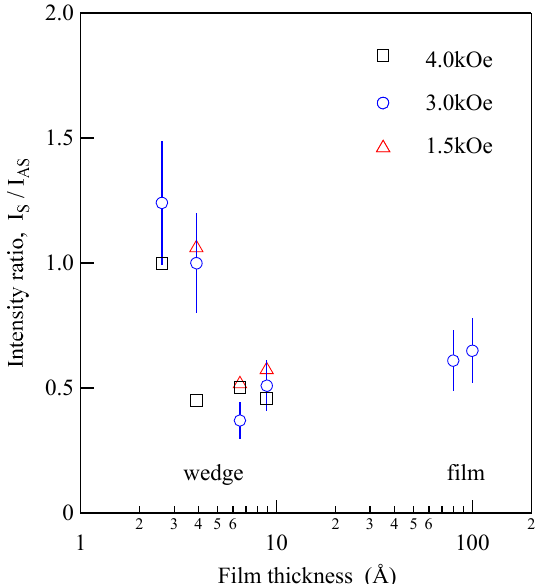
Figure 17. Film thickness and magnetic field dependences of the intensity ratio between the Stokes peak and the anti‑Stokes peak of the Au/Fe/Au films and the wedge [61].